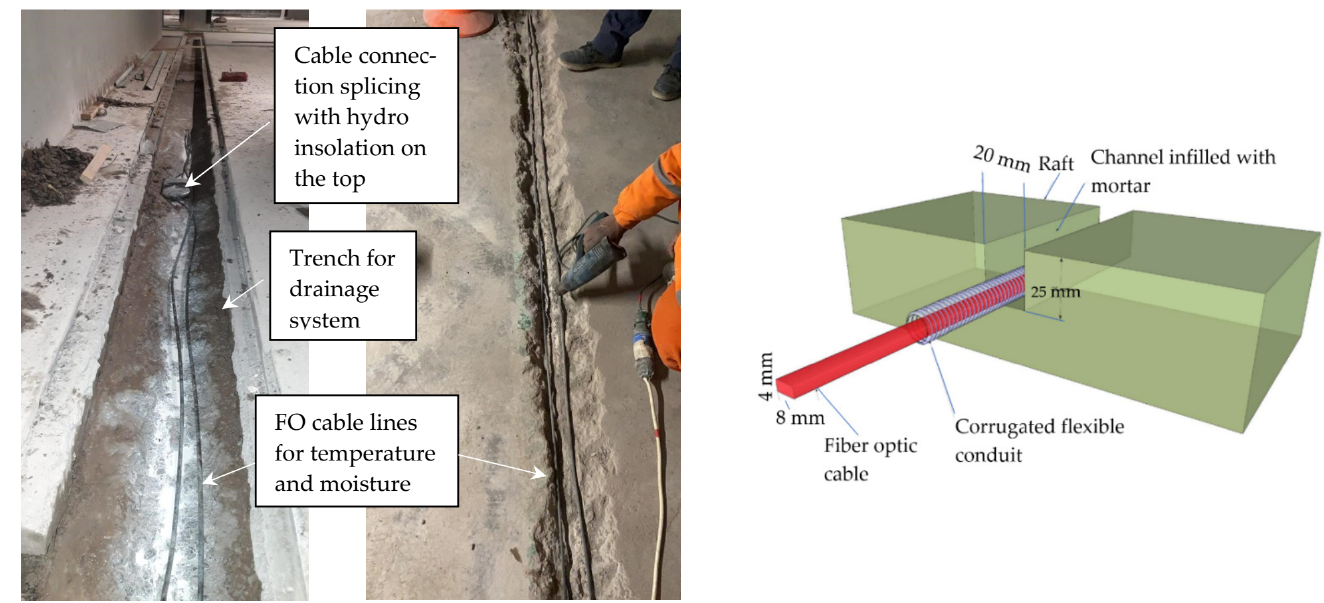
Figure 7. Installment of fiber optic sensors on the concreate surface.